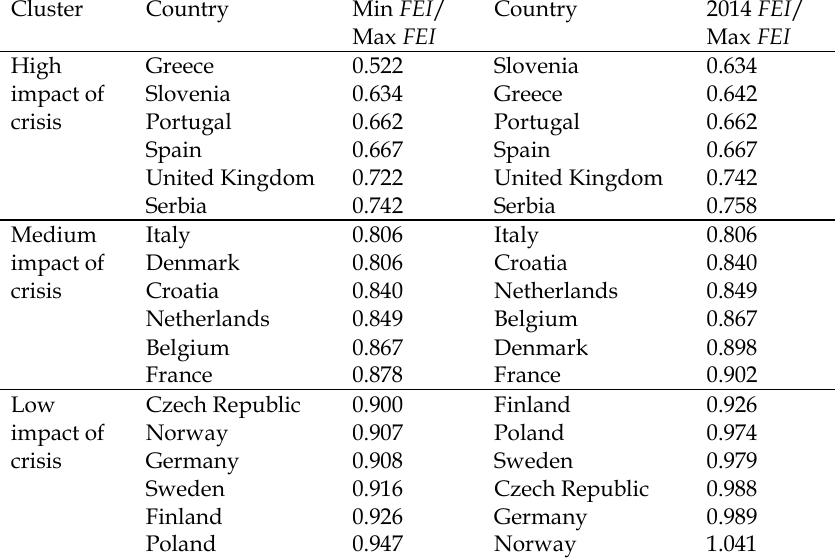
Clustering of countries according to impact of